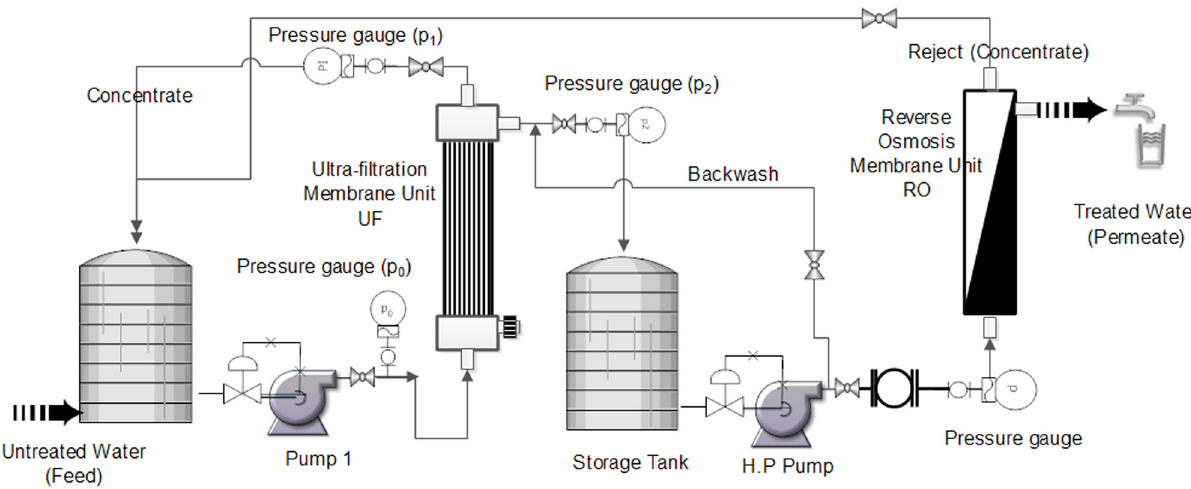
Figure 8: Hybrid ultra fi ltration - reverse osmosis membrane system for virus removal from domestic